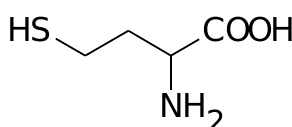
Figure 1. Structural formula of homocysteine (M r = 135.2).